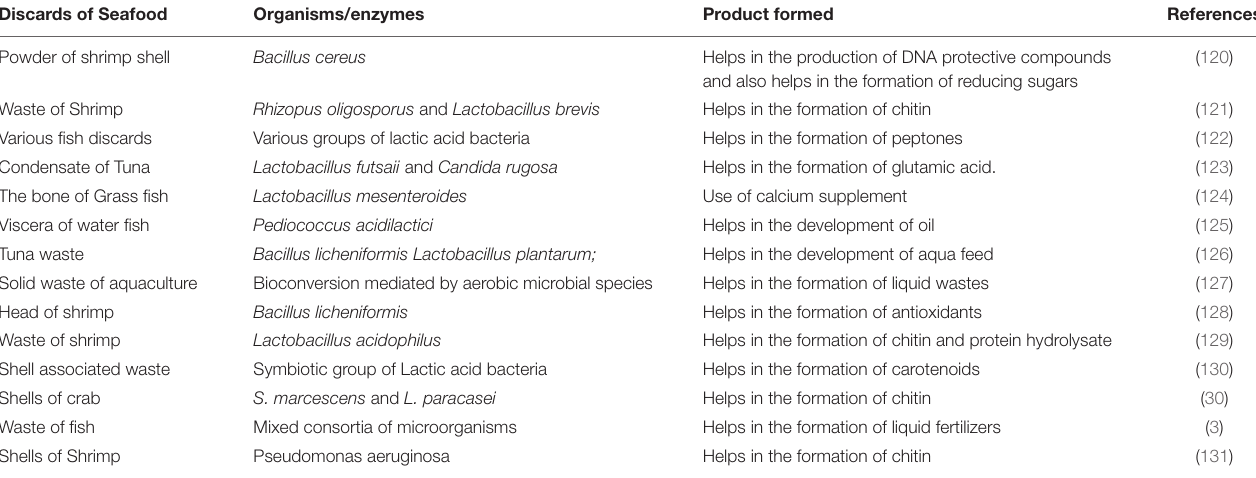
TABLE 2 | Valorization of sea discards by